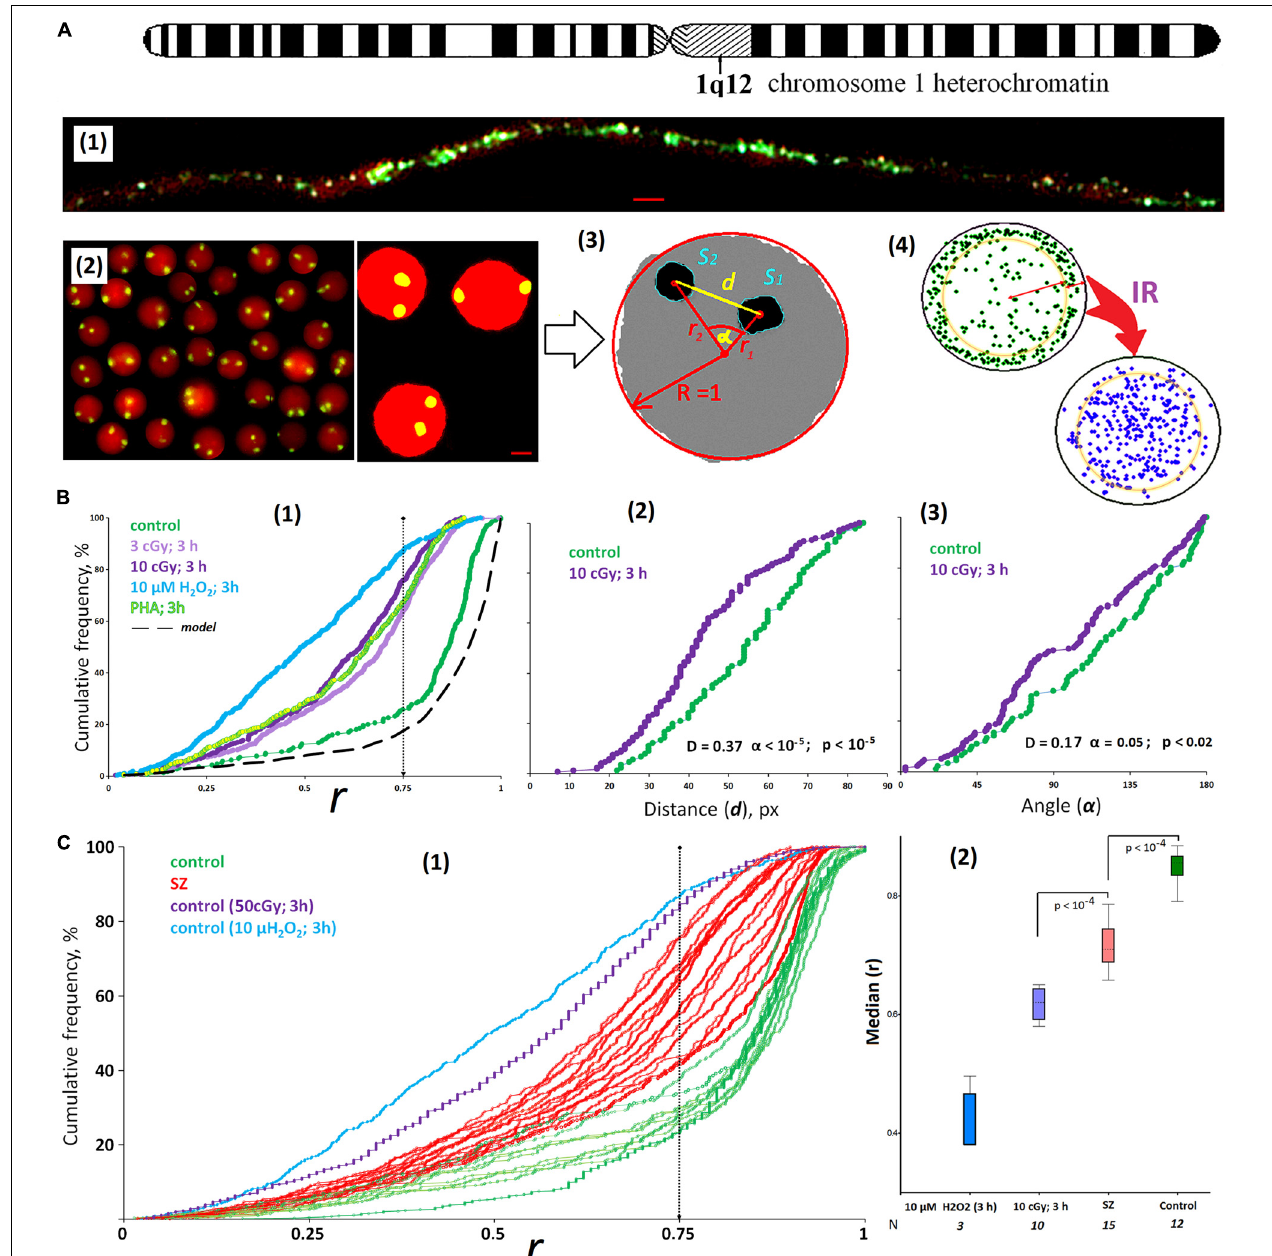
FIGURE 1 | ROS induces the movement of 1q12 loci from the membrane into the nucleus. (A) (1) Fiber-FISH chromatin 1q12 analysis with the f-Sat III probe PUC1.77. Repeat clusters of f-SatIII (green) alternate with other repeats (red, PI) of a given region of the chromosome 1. (2) The example of the FISH result obtained for the control cells. 1q12 loci are represented in the nucleus (red, PI) by two fluorescent signals (green). Gallery of the cells was formed from multiple photos. Bars, 5 µ m. (3) Example of the nucleus image analysis. Image processing includes determining the center of gravity of the FISH signal, the radius vectors of the signals ( r 1 and r 2), the distance and angle between the signals ( d and α ), the area of the FISH signals ( S 1 and S 2), and radius R and area S of the nucleus. The radius vector r is normalized to the value of the radius of the nucleus R and varies from 0 (center of the nucleus) to 1 (surface of the nucleus). (4) The total arrangement of FISH signals on the plane in the control sample (green) and the irradiated sample (violet). In the control nuclei, signals with r > 0.75 are more common. In irradiated nuclei (10 cGy, 3 h), signals with r < 0.75 are more common. (B) (1) Cumulative histograms of the frequency distribution of the FISH signals by the radius vector r (0: center of the nucleus) for intact, irradiated (3 and 10 cGy), H 2 O 2 -treated, and PHA-stimulated G0 human lymphocytes. Dotted line, 3D–2D simulation under the assumption that FISH signals are located on the surface of a flattened sphere modeling the cell nucleus located on the slide. Note: distributions of the r values for irradiated HC (3 and 10 cGy) differ significantly from non-irradiated HC: D = 0.51, α < 10 − 34 (Kolmogorov–Smirnov); p < 10 − 50 ( U -test). (2,3) The distance and angle between the two FISH signals for intact and irradiated (10 cGy) human lymphocytes. (C) (1) Cumulative histograms of the frequency distribution of the FISH signals by the radius vector r for HC ( N = 10) and SZ groups ( N = 15). (2) The values of the medians of the radius r for the HC group, for irradiated or H 2 O 2 -treated HC cells, and for the SZ cells. Note: Before the FISH nuclei were treated with RNase A.